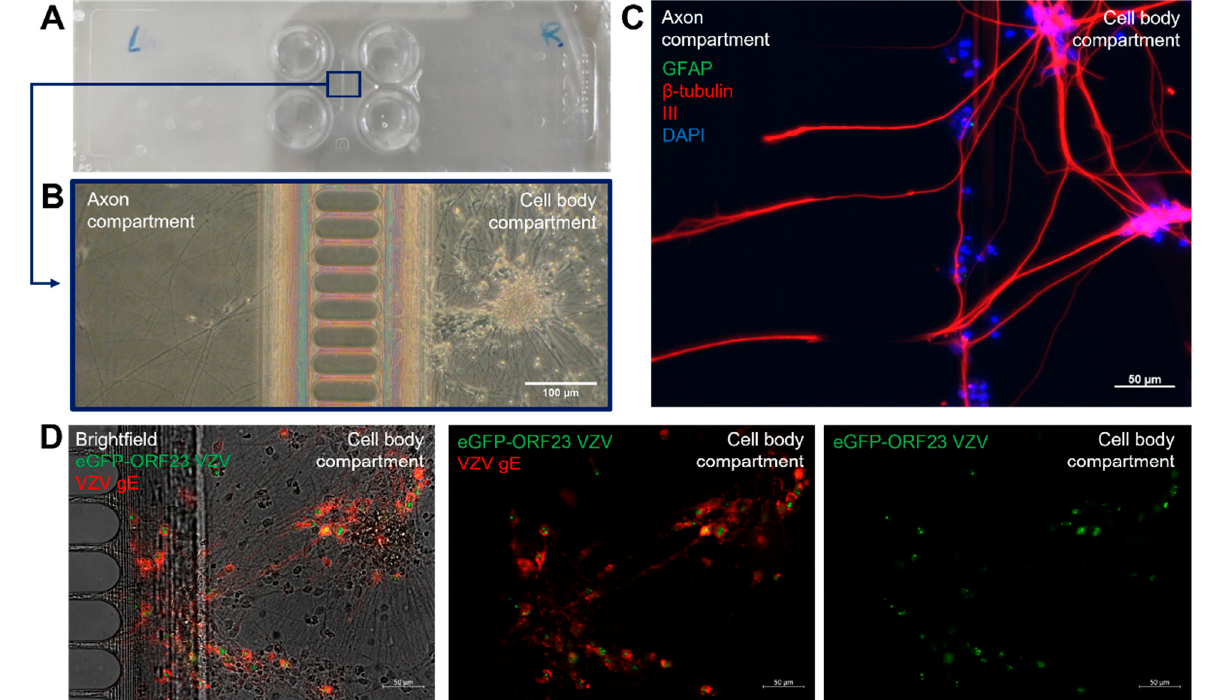
Figure 2. Generation of a compartmentalized neuronal culture model suitable for axonal VZV infection. ( A ) Image of a XonaChipTM (XC150). The two left wells and two right wells are separated from each other through a microgroove barrier (150 µm length, 10 µm width). ( B ) Brightfield image of a hiPSC-derived neuronal culture showing separation of cell bodies from axon termini. Representative image (at 18 dpd) with images that were acquired between 7 dpd and 21 dpd. ( C ) hiPSC-neuronal cultures were stained with mouse anti- β -tubulin III and rabbit anti-GFAP primary antibodies in combination with goat anti-mouse AF555 (red) and goat-anti rabbit FITC (green) secondary antibodies. Nuclei were stained with DAPI (blue). Representative image (at 13 dpd) with images that were acquired between 7 dpd and 21 dpd. ( D ) Spreading of eGFP-ORF23 VZV in the cell body compartment following inoculation of axon termini. Images show expression of eGFP, arising from the VZV capsid protein ORF23, and VZV gE which was stained with mouse anti-VZV gE primary antibody in combination with rabbit anti-mouse AF555 (red) secondary antibody. Representative image at 7 dpi (28 dpd).